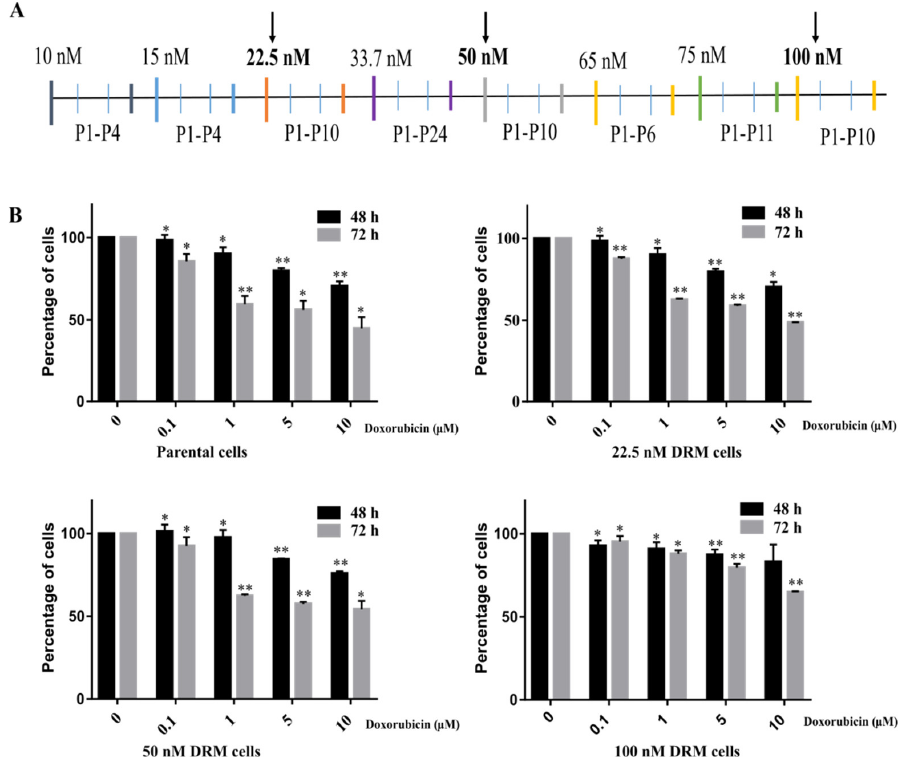
Figure 1. The schedule for the establishment of DRM cells and cell viability of DRM cells with ( A ) MDA-MB-231 human breast cancer cells were treated with doxorubicin with the increasing concentration ranges from 10 nM to 100 nM. Based on the human plasma concentrations of doxorubicin, the final concentration (100 nM) was designed. The cells were treated and maintained with doxorubicin, and the number of passages is represented as P1, P2… Cells were maintained in doxorubicin-containing media for 38 weeks. ( B ) The cell viability assay for the three clones (22.5, 50 and, 100 nM DRM cells) that showed morphological changes while establishing doxorubicin-resistant cells. The cells showed resistance to doxorubicin as compared to parental cells. The values expressed as mean ± standard deviation (SD) (n = 5) (* p < 0.05 vs. control; ** p < 0.001 vs. control). DRM: Doxorubicin-resistant MDA-MB-231.